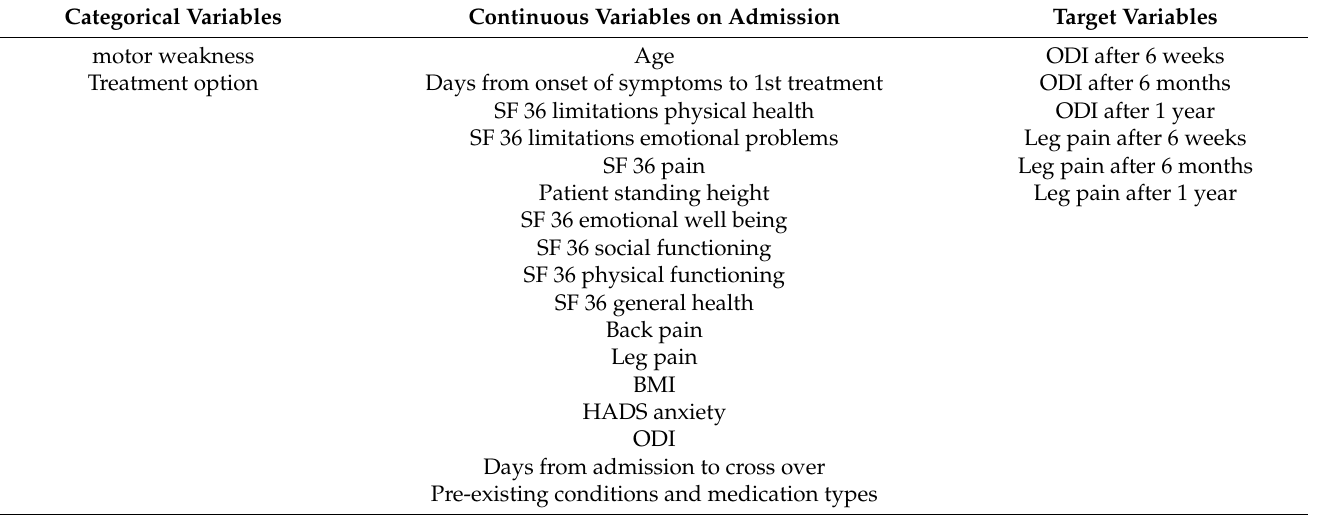
Table 3. Variables identified and used for final